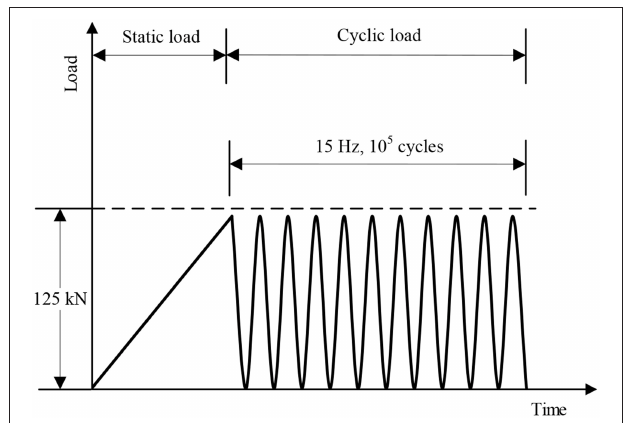
FIGURE 9 | Cyclic loading